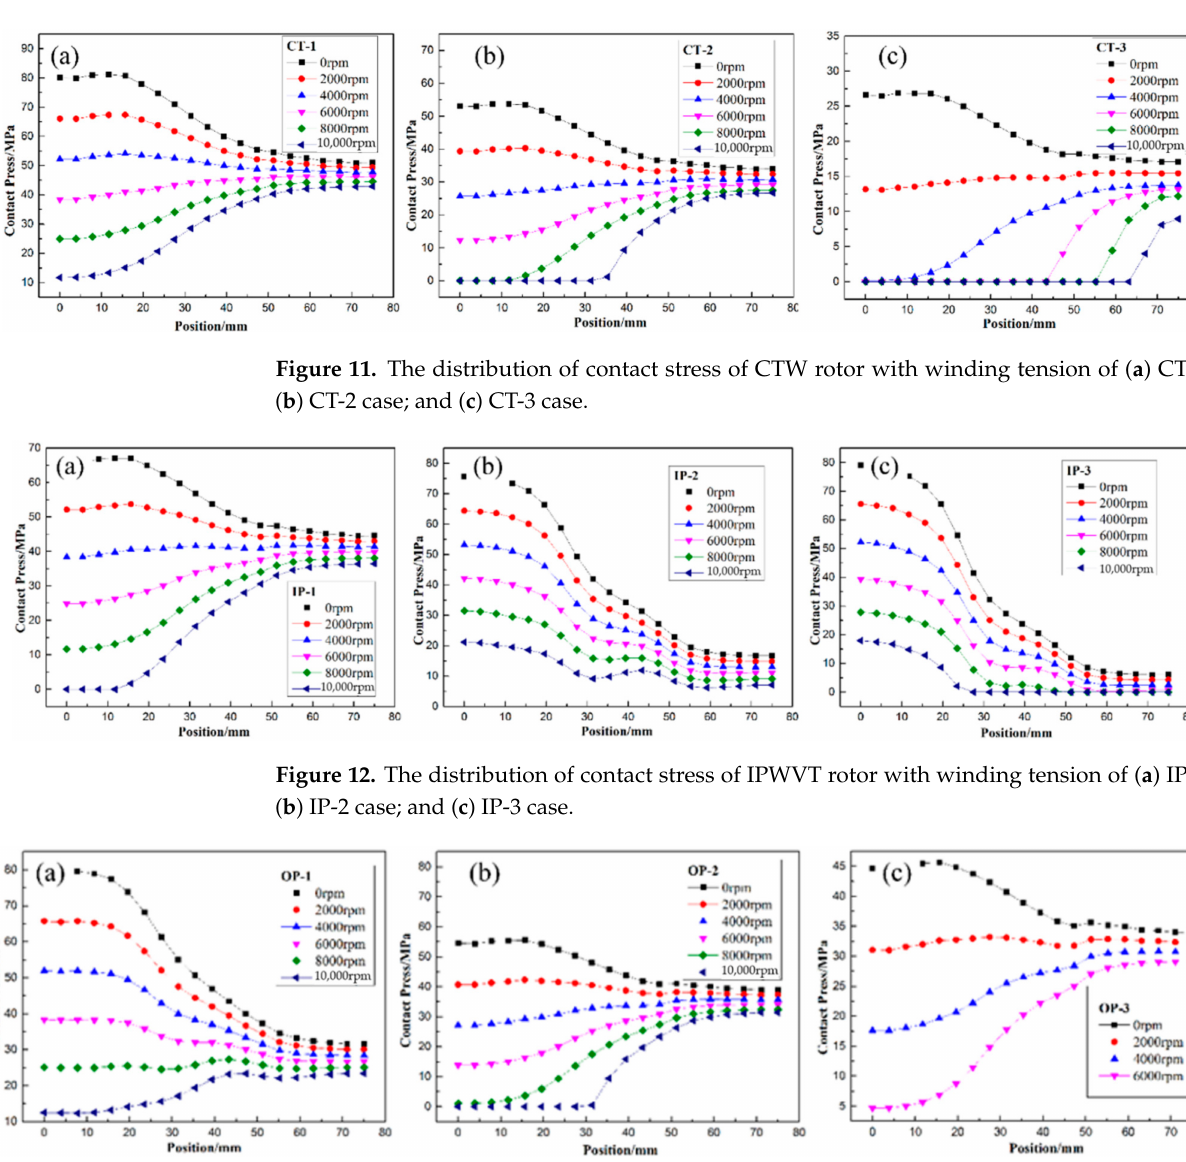
Figure 13. The distribution of contact stress of OPWVT rotor with winding tension of ( a ) OP-1 case; ( b ) OP-2 case; and ( c ) OP-3